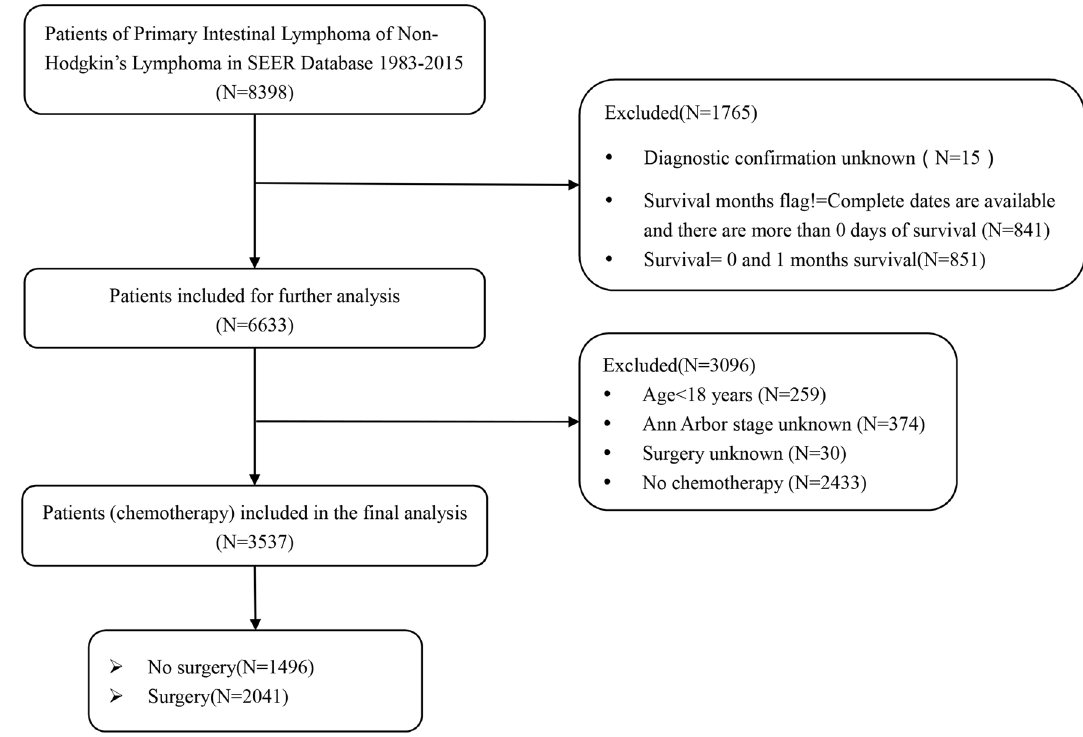
Figure 1. The Flowchart of inclusion and exclusion